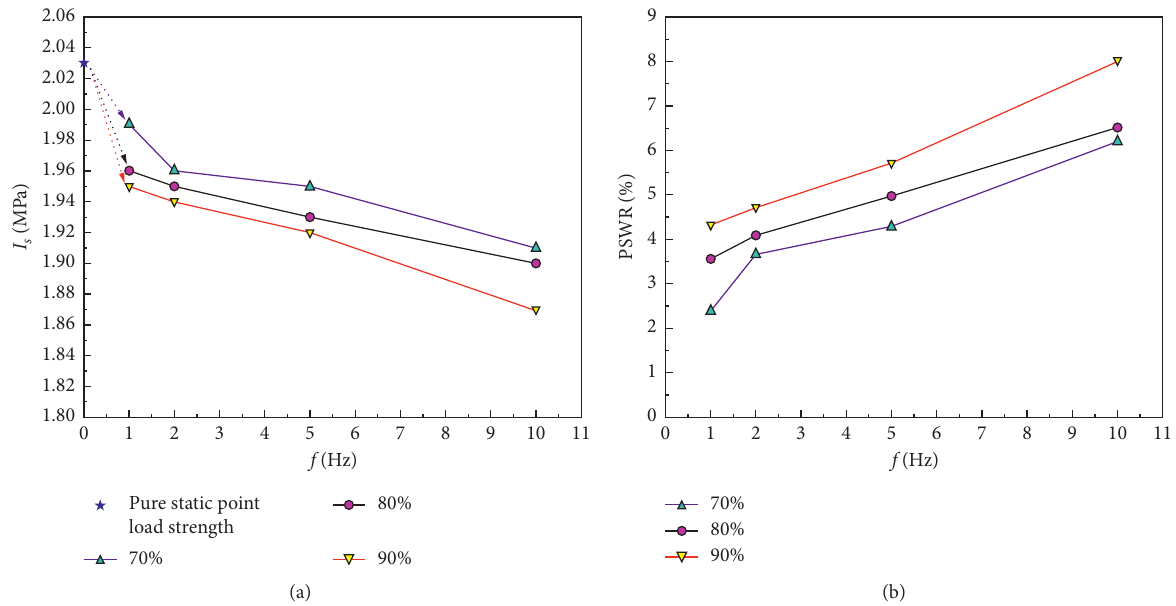
Figure 8: The point load strength and the corresponding weakening rate change trend with the disturbance frequency. (a) Point load strength. (b) PSWR.